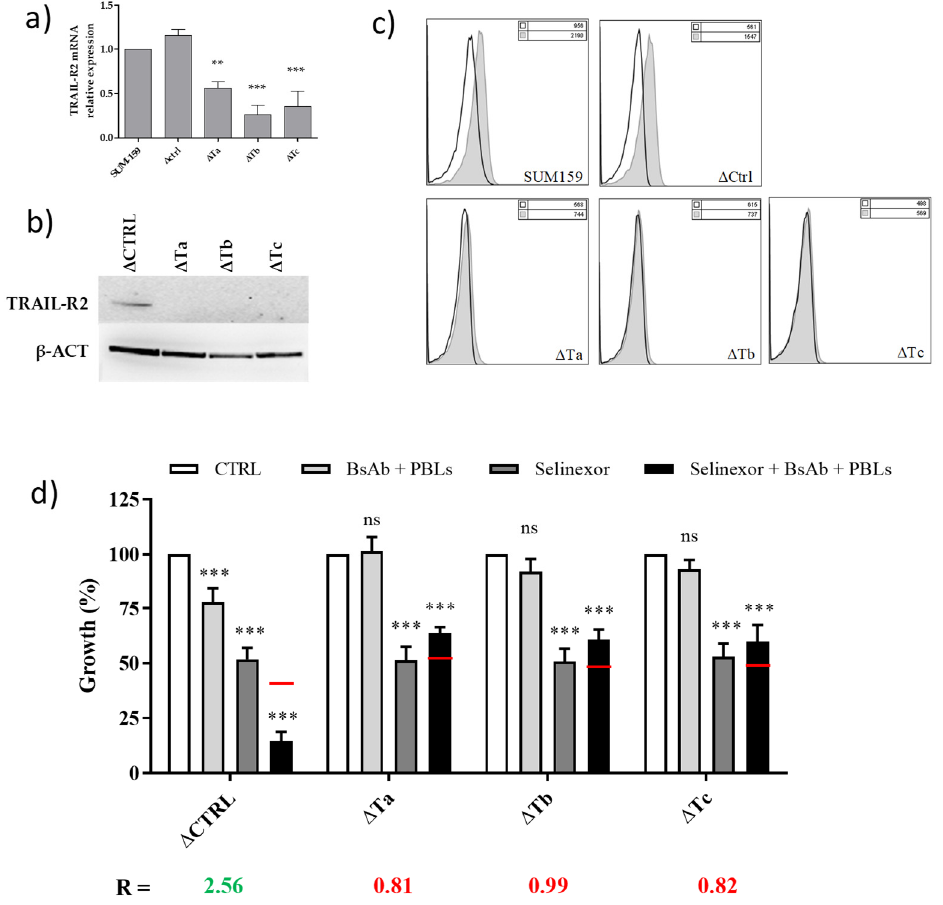
Figure 3. Cytotoxic e ff ect of selinexor and TRAIL-R2xCD3 BsAb combination in SUM-159